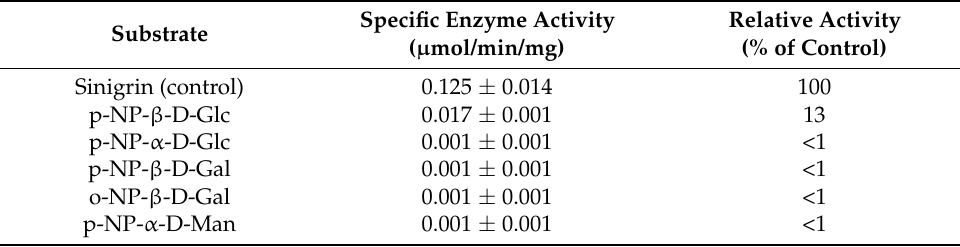
Table 3. Enzyme activities of the myrosinase from the seeds of L. sativum on various p-/o-nitrophenyl monosaccharide